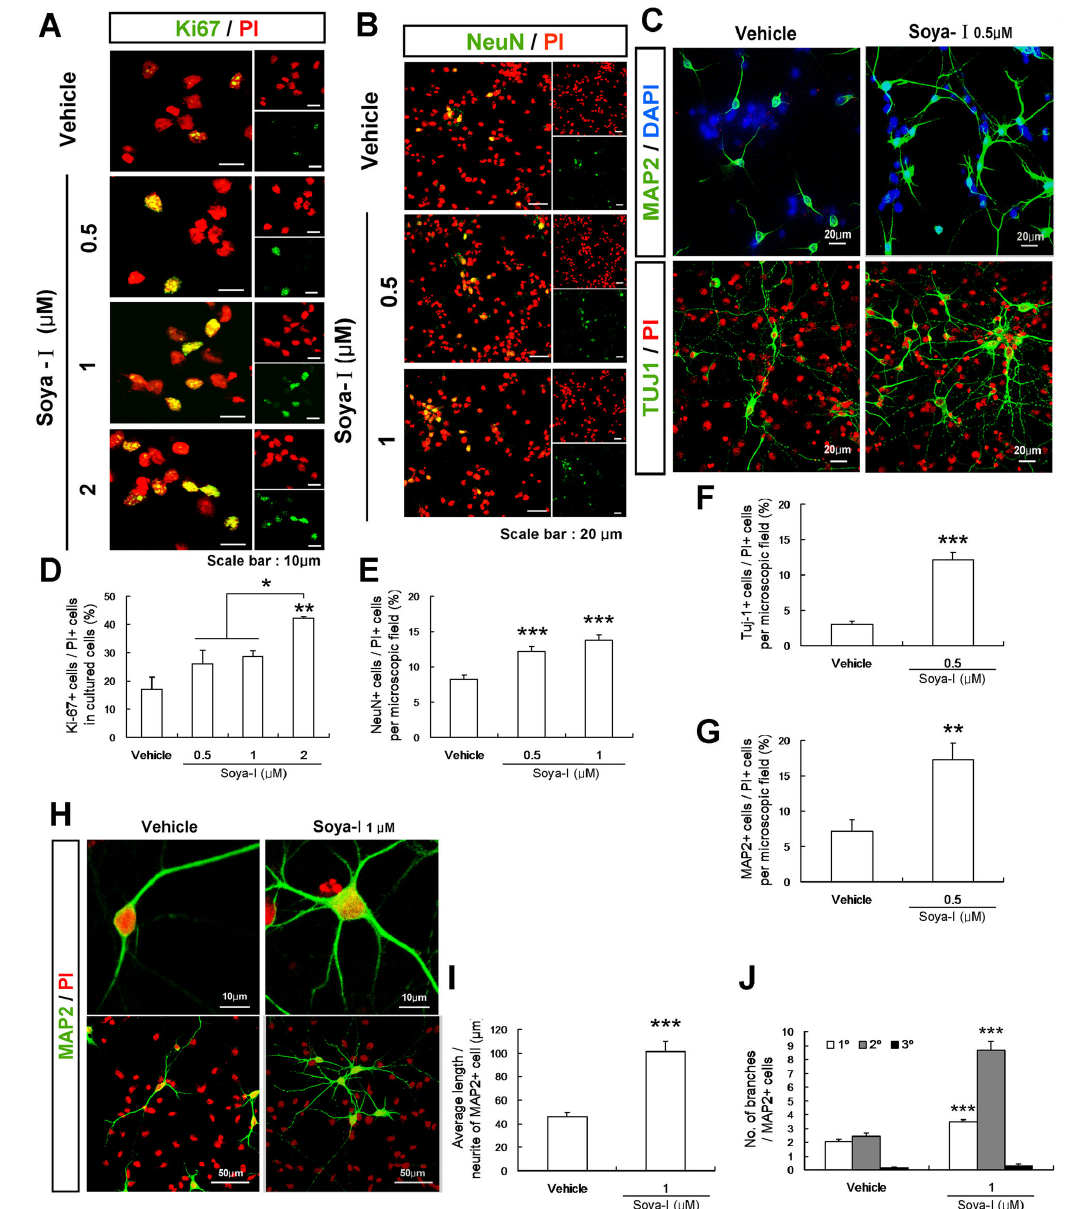
Figure 6. Proliferation and maturation of NPCs and neurite outgrowth of MAP2-positive neurons increased by soya-Ι among cultured hippocampal cells. A. Confocal laser scanning microscopic images of Ki67-positive NPCs (green: Ki67-positive cells, red: PI). B. Confocal laser scanning microscopic images of NeuN-positive cells cultured from the rat embryonic hippocampus (green: NeuN-positive cells, red: PI). C. Confocal laser scanning microscopic images of MAP2 and TUJ1-positive NPCs (green: TUJ1-positive cells and MAP2-positive cells, red: PI). D. Average percentages of Ki67-positive cells, E. Average numbers of NeuN- positive cells, F. Average numbers of TUJ1-positive cells, G. Average numbers of MAP2-positive cells compared with PI-positive cells per microscopic field. H. Confocal laser scanning microscopic images of MAP2-positive cells cultured from the rat embryonic hippocampus (green: MAP2-positive cells, red: PI). I. Average neurite length of MAP2-positive cells with neurites longer than double the cell body width. J. The average number of branches per MAP2-positive cell, where the length of the primary branches is two-fold longer than the width of the cell bodies. All assays and counting were carried out as described in Materials and Methods. Over ten positions per cover slip (three times of Ki67, NeuN, TUJ1, and MAP2 immunostaining assay per one trial hippocampal primary culture carried out) were selected and counted. Data represent means ± SEM. ( * p <0.05, ** p <0.01, *** p <0.001, compared with the vehicle group by the Newman-Keuls Multiple Comparison Test (D,E) or unpaired t test (F, G, I, J)). doi: 10.1371/journal.pone.0081556.g006 PLOS ONE |